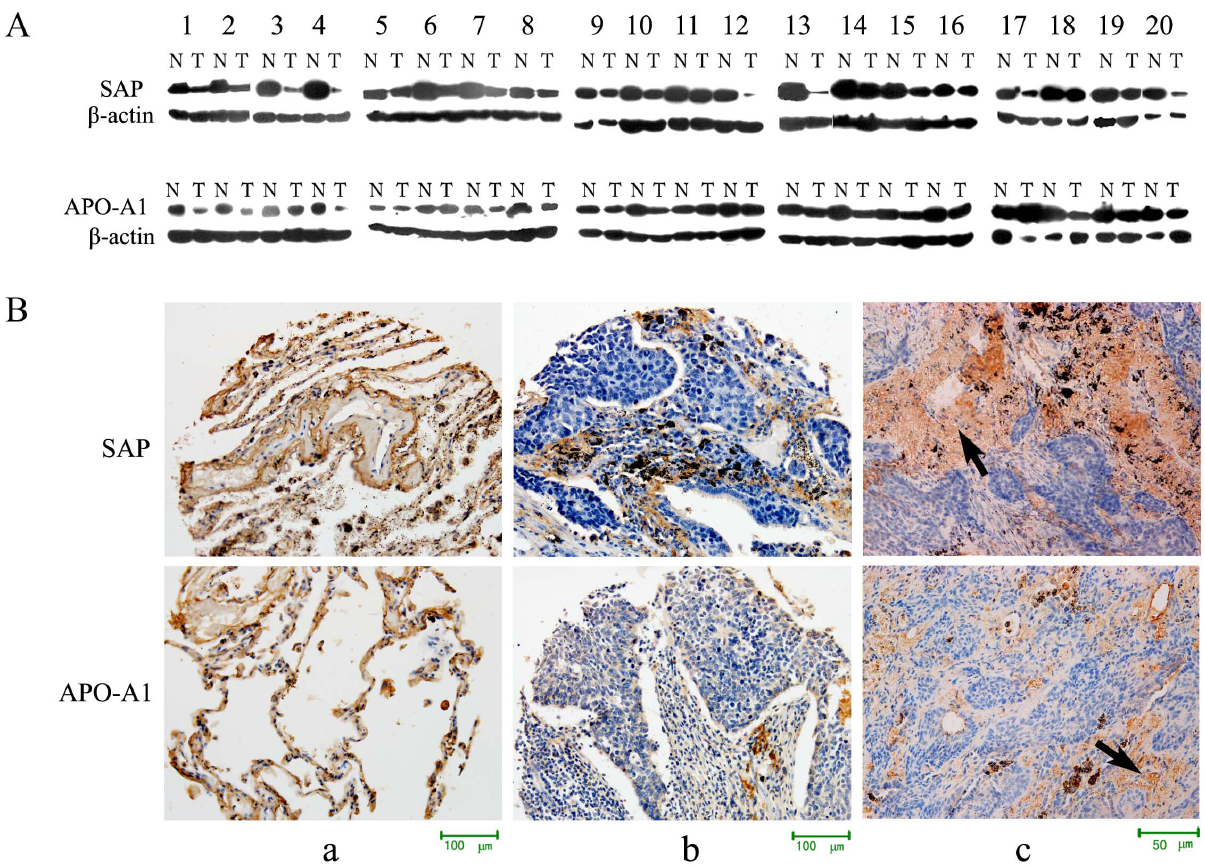
Figure 4. Expression of apoA1 and SAP in lung cancer and normal tissues. (A) Western blot analysis detected expression of apoA1 and SAP in 20 pairs of lung SCC and adjacent normal tissues. There was low expression of apoA1 and SAP in tumor tissues, and the differences in apoA1 and SAP expression in SCC and normal tissues were statistically significant, P=0.033 and 0.001, respectively. (B) (a) Expression of apoA1 and SAP in normal tissue. Immunohistochemical analysis showed apoA1 and SAP as localized in the cell membrane and cytoplasm x200. (b and c) Expression of apoA1 and SAP in lung cancer tissues x200 and x400. Immunohistochemical analysis showed apoA1 and SAP were localized in the peripheral and central necrotic tissue of the cancer nest, but only slightly or not expressed in the cancer cells.